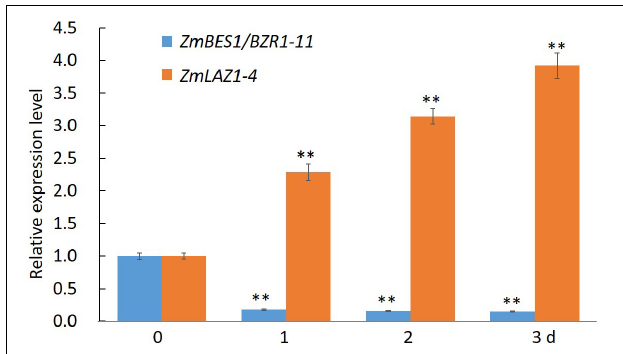
FIGURE 6 | Relative expression level of ZmLAZ1-4 and ZmBES1/BZR1-11 in response to Zn deficiency. ∗∗ p < 0.01.